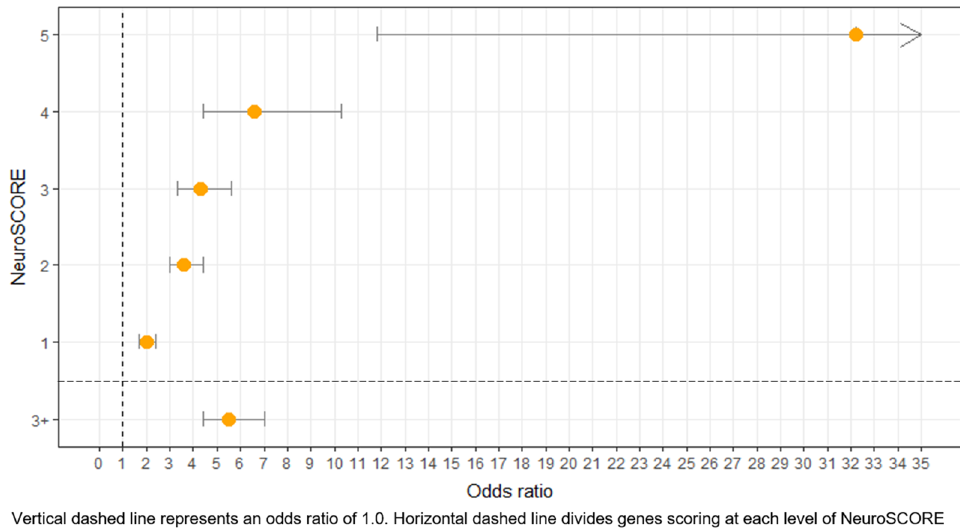
Figure 2. Odds ratio of genes associated with CNS-related phenotypes by NeuroSCORE.